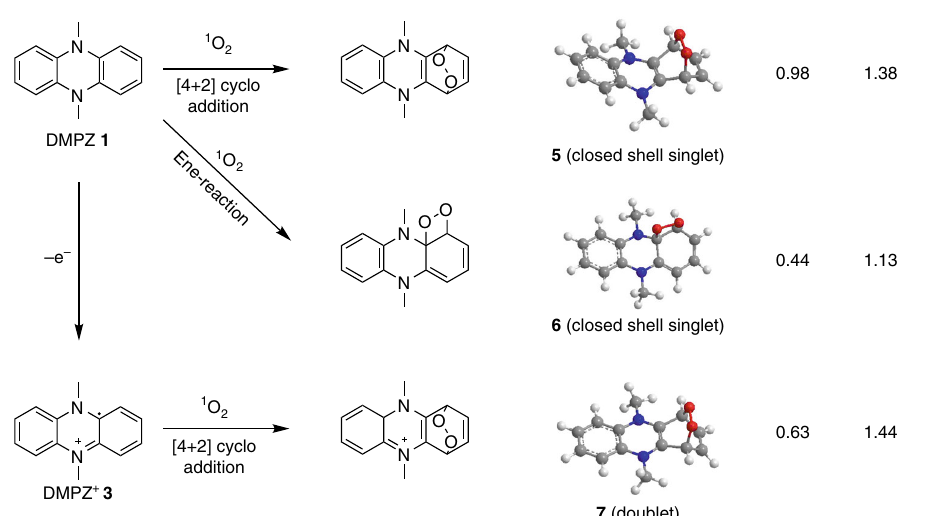
Fig. 4 Reactions and energetics of reactions between DMPZ and 1 O 2 . Possible reactions of DMPZ/DMPZ + with 1 O 2 , B3LYP/6 – 31G* optimized geometries of the reaction products, and DFT-calculated free energies at 298 K ( Δ G) and the barriers for these reactions ( Δ G ‡